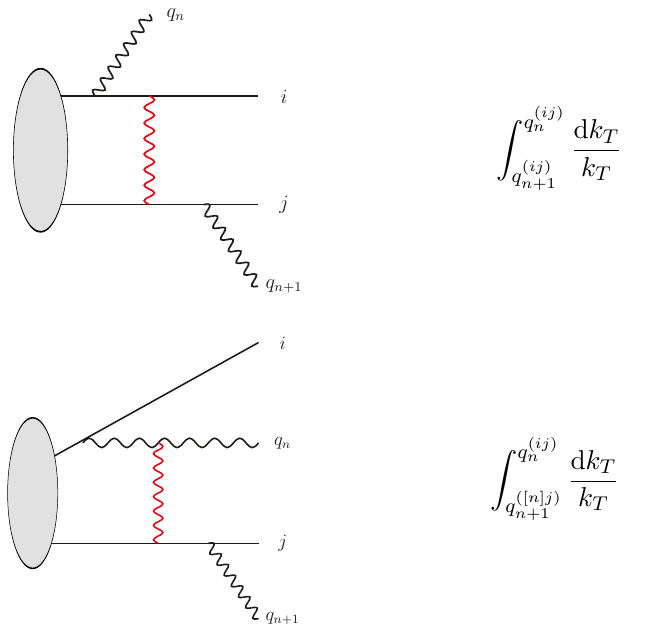
Figure 1 . Illustrating how the ‘dipole transverse momentum’ serves to limit the virtual loop integration. The index [ n ] refers to the gluon with momentum q n